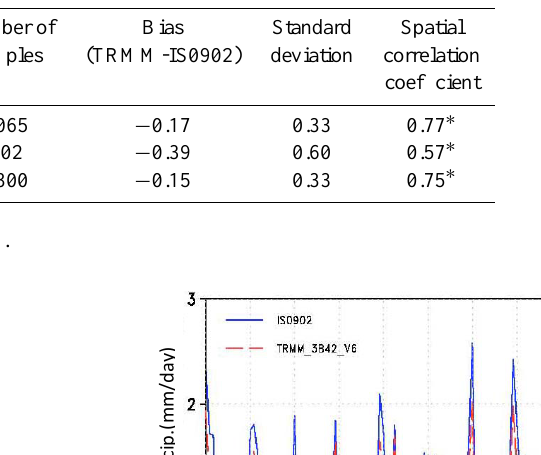
Table 1. Statistical parameters of linear regression and spatial correlation coefficient in Fig. 7.